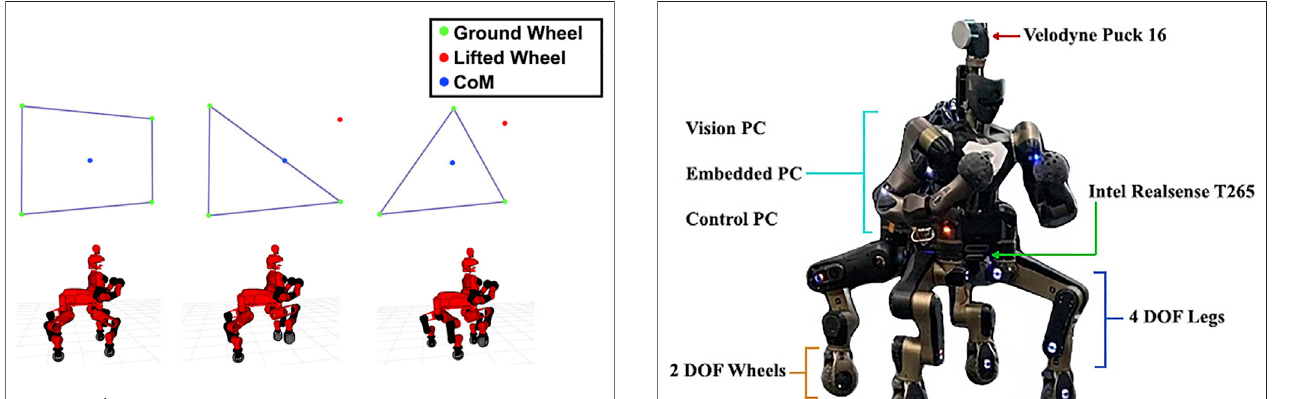
FIGURE 6 | (A) Initial con fi guration, in which the wheels (green dots) are all in contact with the ground and the support polygon is a rectangle. (B) The result of lifting one wheel (red dot) without moving the others. Here the CoM (blue dot) is on the edge of the polygon. (C) The selected approach, where we move a wheel in order to obtain a more suitable support polygon with borderlines further than the location of the CoM.